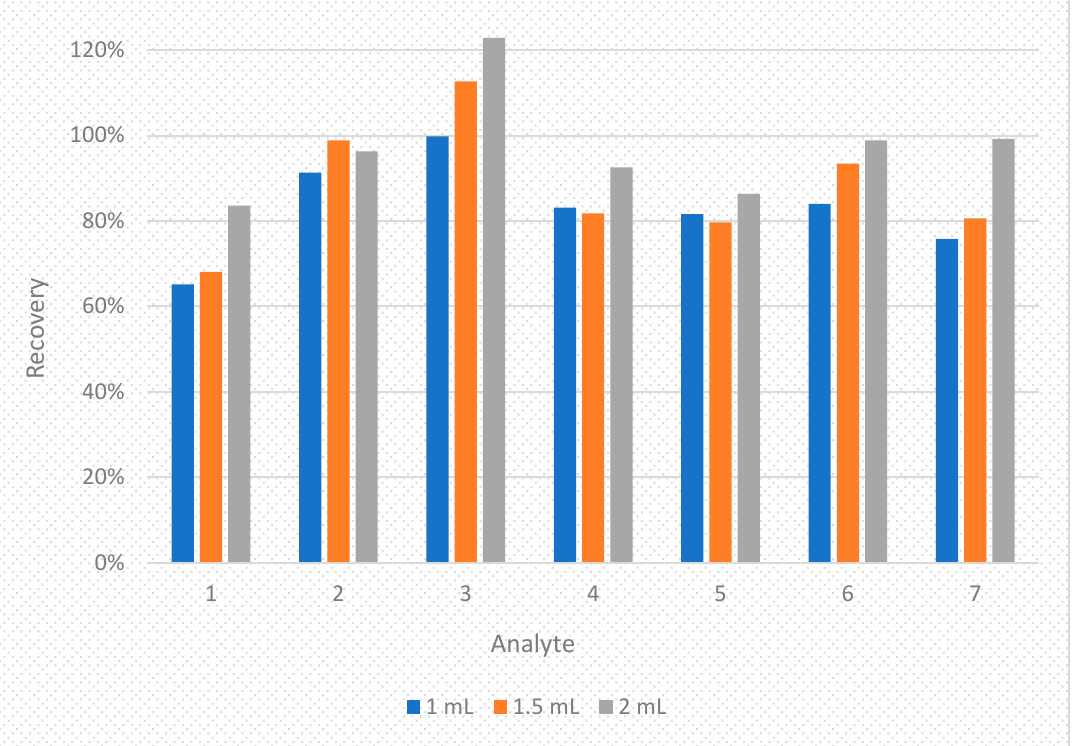
Figure 4. The diagram of comparison of the recoveries obtained by adding three different volumes of extraction mixture (1 mL, 1.5 mL and 2 mL) for seven bisphenols in spiked human breast milk samples. 1—BADGE ∙ 2H 2 O, 2—BPF, 3—BPE, 4—BPA, 5—BADGE ∙ 2HCl, 6—BADGE, 7—BPP.